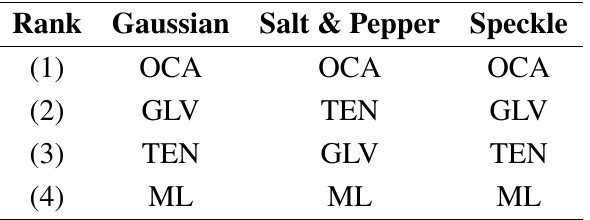
Table 4. Overall rank table of each focus measure in the presence of various